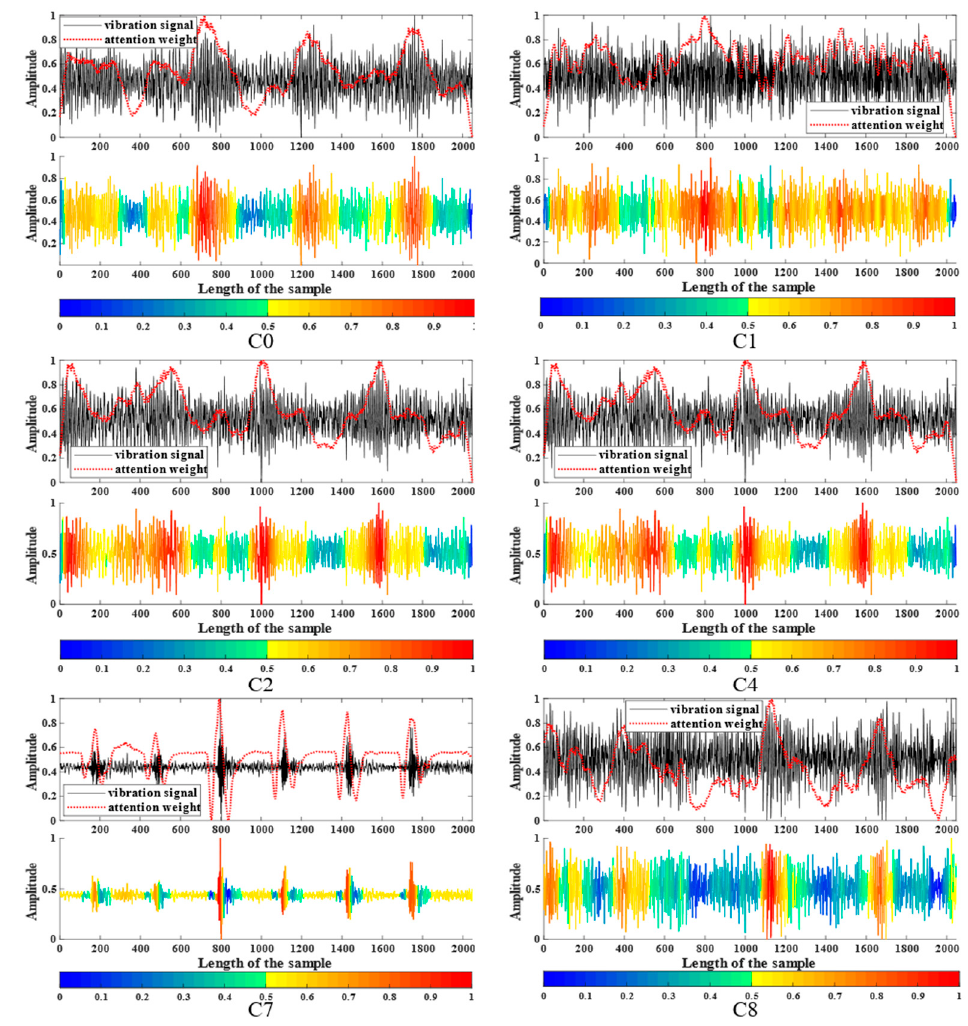
Figure 10. Visualization of partial single-fault attention weights. C0–C8 corresponds to the Pattern Label in Table 2.